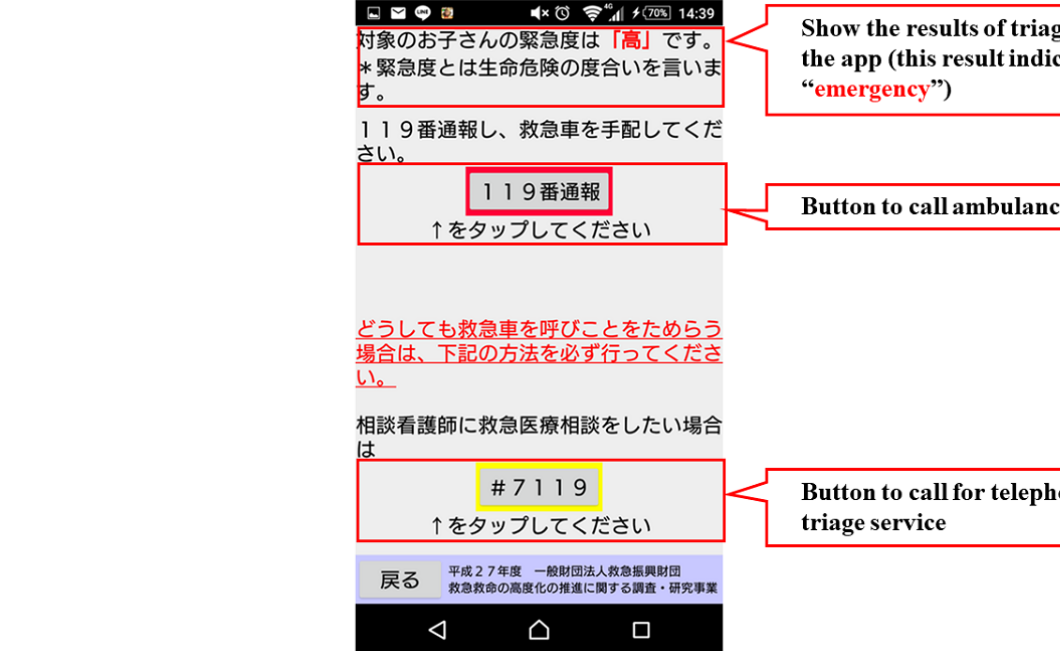
Figure 6. Screenshot of result in emergency cases.